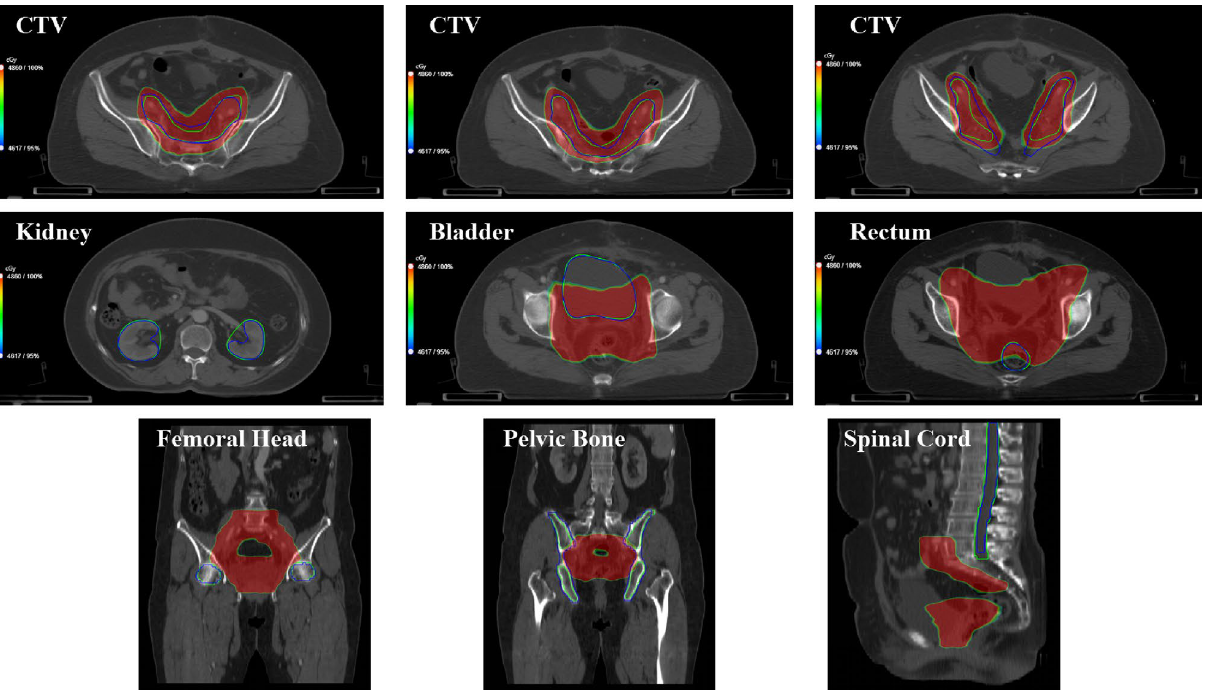
Figure 5. Results of delineations and dose distributions for CTV and OARs in CT slices. The green lines represent manual contours approved by the senior physician; the blue lines represent DL based contours; colourwash represent dose distributions with the range of 95% prescription to 100% prescription.